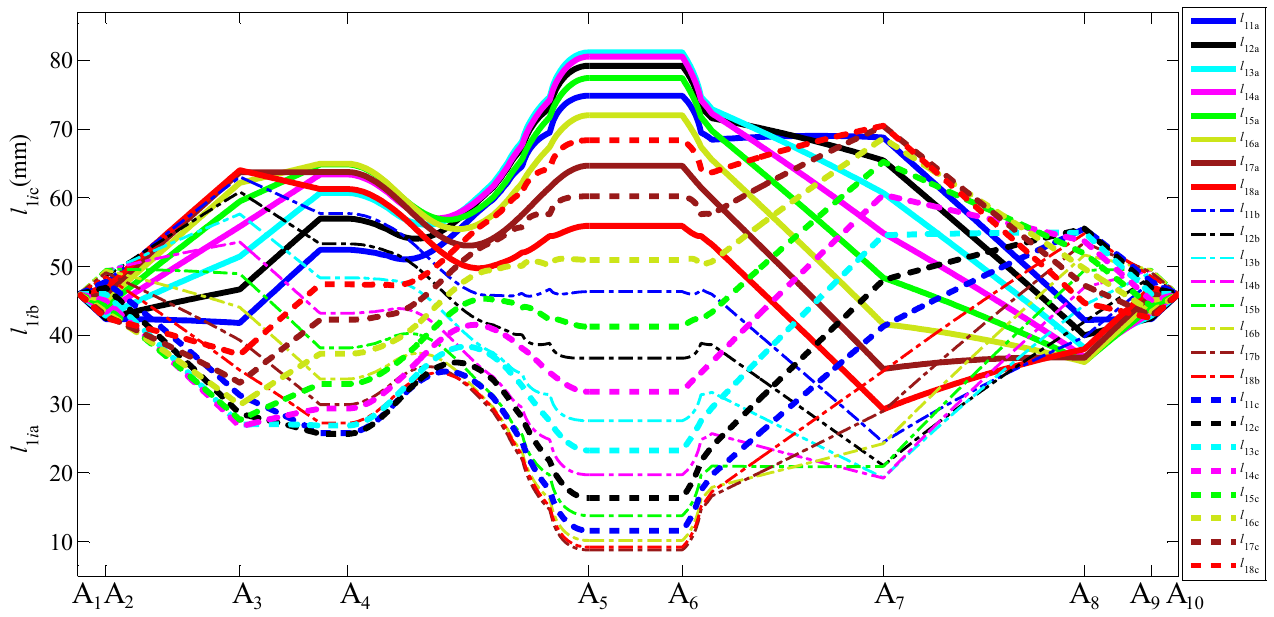
Figure 18. Length change curve of the 24 driving cables at the first joint in obs1.